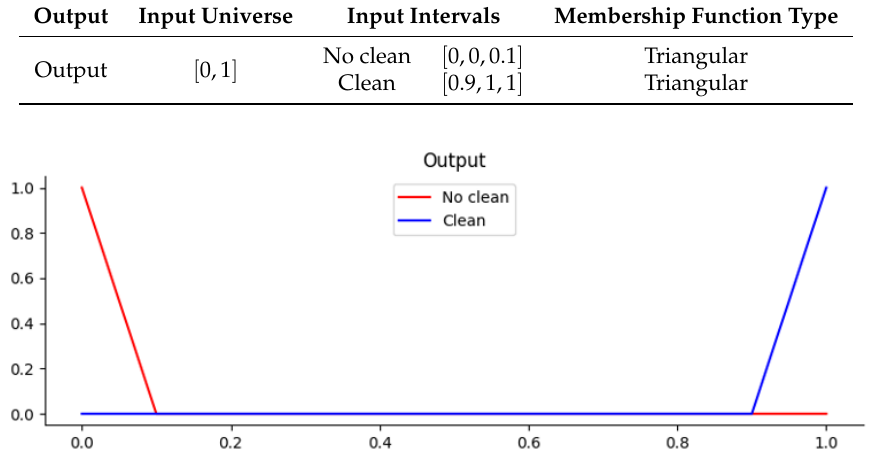
Figure 11. Output’s membership